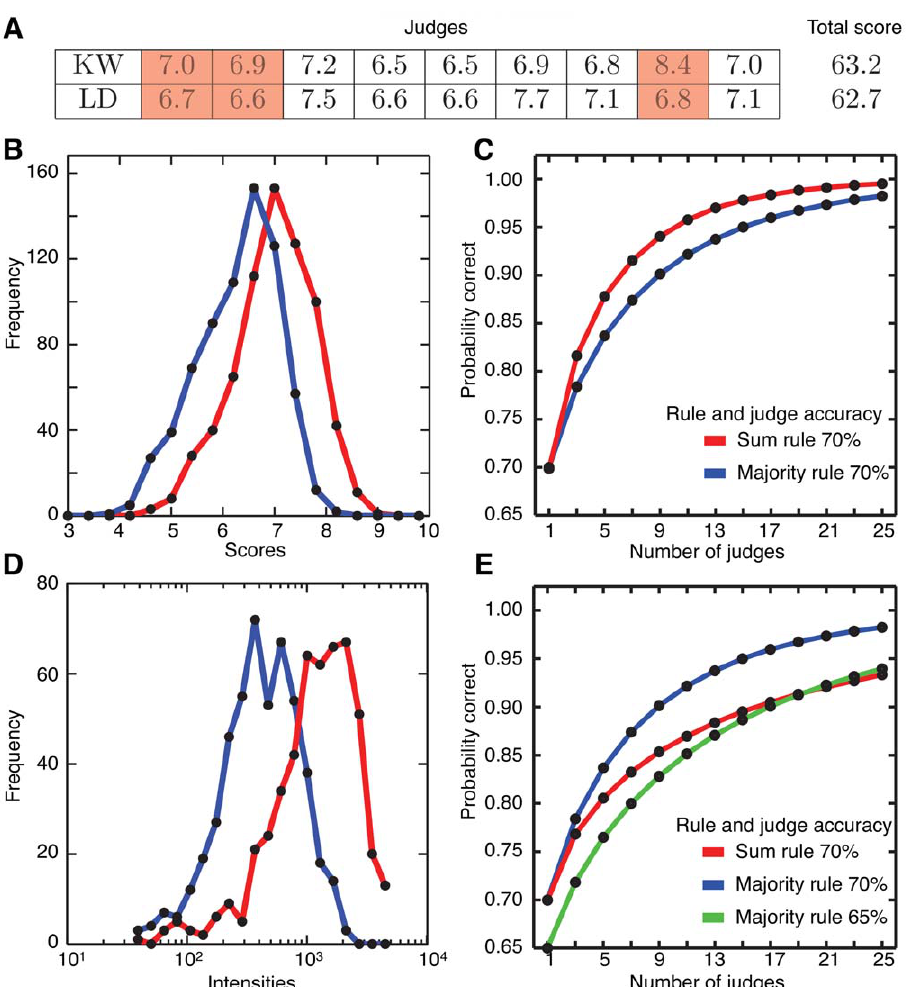
Figure 2. Majority rule versus sum rule. (A) The score-sheets for two competitors in the 2006 US Junior Figure Skating Championship show that while only 3 of the 9 judges (shaded) preferred Competitor KW, she has the higher total score. (B) The histograms show the frequency of scores for skaters ranked 1–5 (red) and those ranked 6–10 (blue). (C) Judge accuracy curves of the sum rule (red) and the majority rule (blue) on a hypothetical problem based on B with judges that are 70% accurate (see Methods). The sum rule is more accurate than the majority rule (confirmed by a nonparametric sign test, p-value v .01 for all cases of more than one judge). (D) The distributions of probe intensities from the Affymetrix Latin Squares data-set measuring 64 picomolar (blue) and 128 picomolar (red) transcripts are very broad. (E) Judge accuracy curves on a model based on D (see Methods) where the judges’ scores come from a wide scoring distribution. The majority rule of judges 70% accurate (blue) outperforms the sum rule of 70% accurate judges (red). In fact a majority rule of judges at 65% accuracy (green) does better than the sum rule of 70% accurate judges as the number of judges increases beyond 21. A nonparametric sign test confirms the differences in performance (p-value v .01) for all cases of more than one